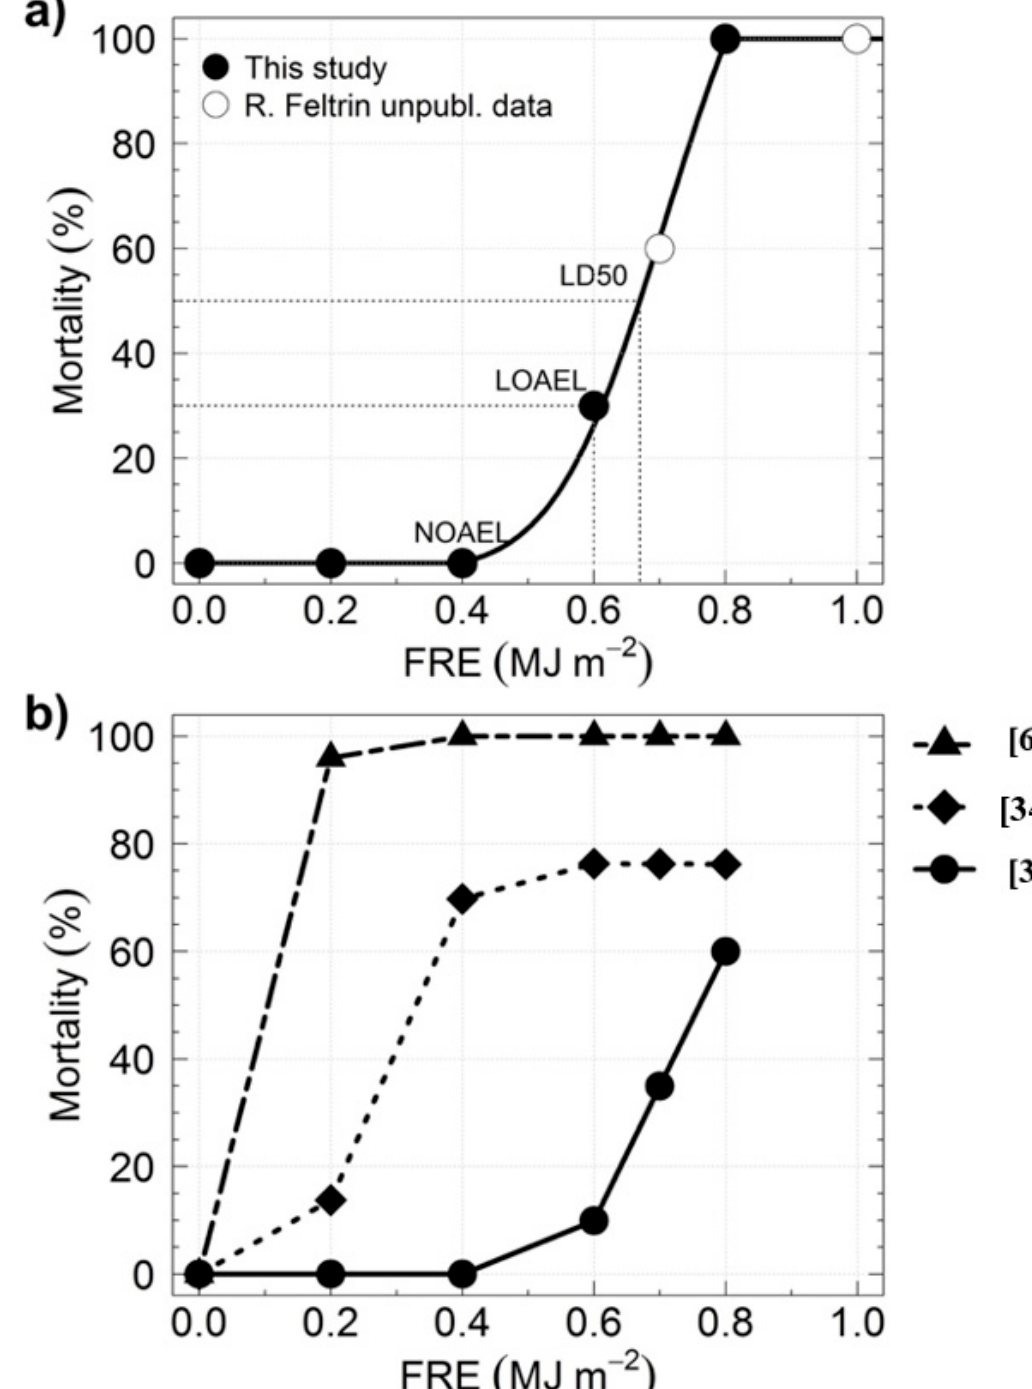
Figure 3. Mortality dose-response curve for Pinus ponderosa saplings. ( a ) Mortality as a function of FRE dose for 2.5-year-old Pinus ponderosa saplings in the current study. Unpublished data from a companion study (R. Feltrin unpubl. data) is also shown. ( b ) Equivalent dose-response curves of mortality produced using the logistic regression equations as a function of the FRE dose applied in the current study. Ancillary pre- and post-fire data collected for each sapling were used to create these dose-response curves using eqns (1–4) described in the methodology.